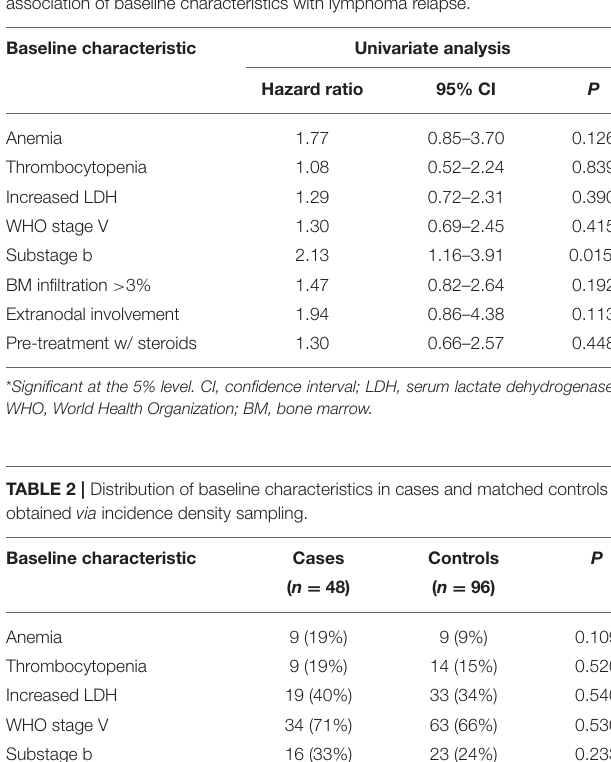
TABLE 1 | Results of Cox proportional hazards regression analysis: univariable association of baseline characteristics with lymphoma relapse.